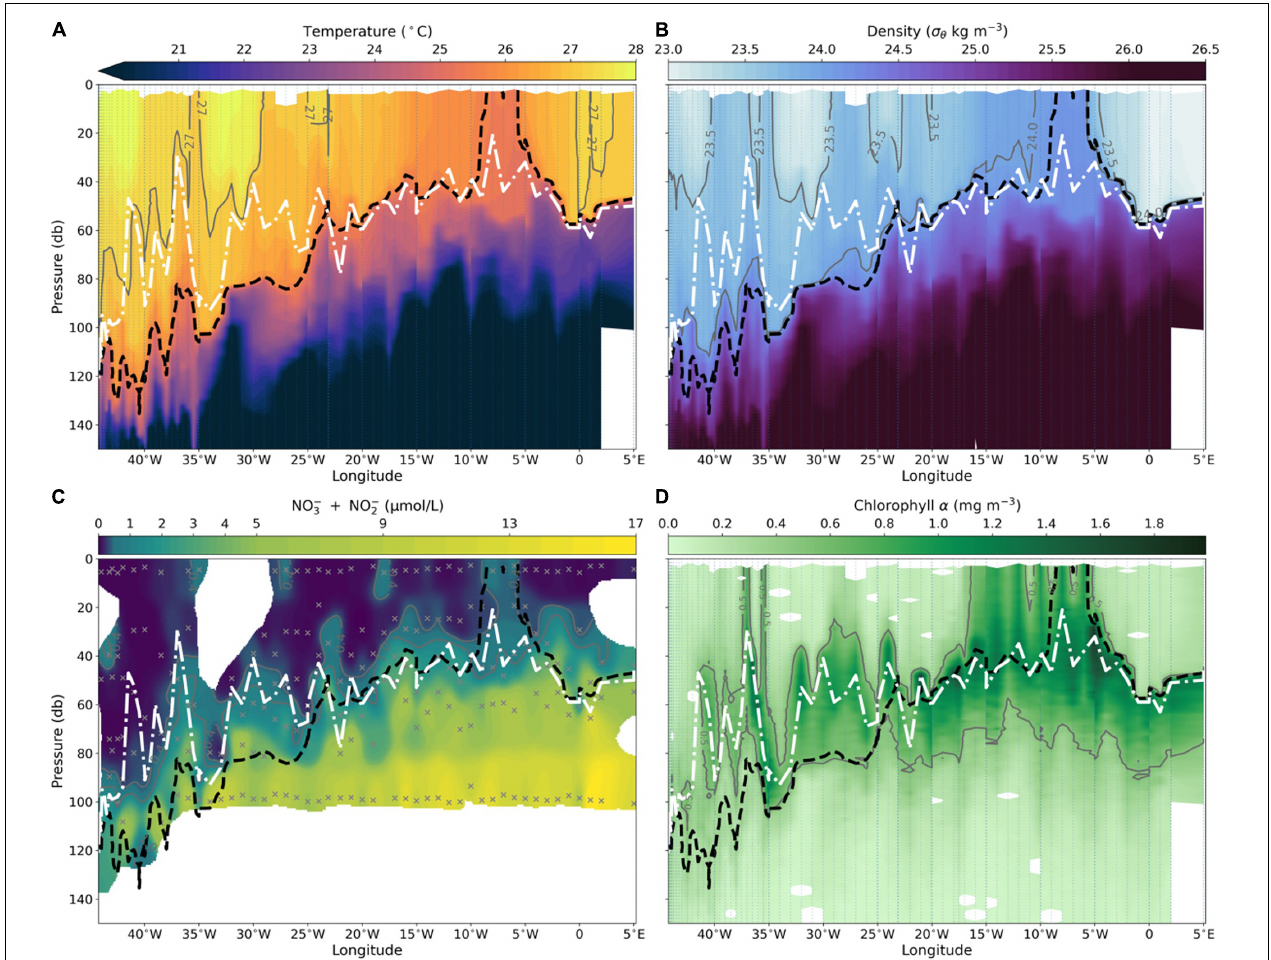
FIGURE 2 | Section plots along the Equator of physical and biophysiochemical parameters. (A) Temperature (from CTD), (B) potential density (from CTD), (C) nitrite + nitrate (sampled from Niskin bottles) and (D) chlorophyll a (measured by a CTD mounted fluorometer). Note that the color bar in (C) is non-uniform in order to highlight changes across orders of magnitude. Gray dotted lines in plots (A,B,D) denote the CTD stations. Black X in plot (C) , represent the Niskin bottle sampling locations. Black dashed line and white dash-dot line in each panel represent the 25 ◦ C isotherm and the DCM,